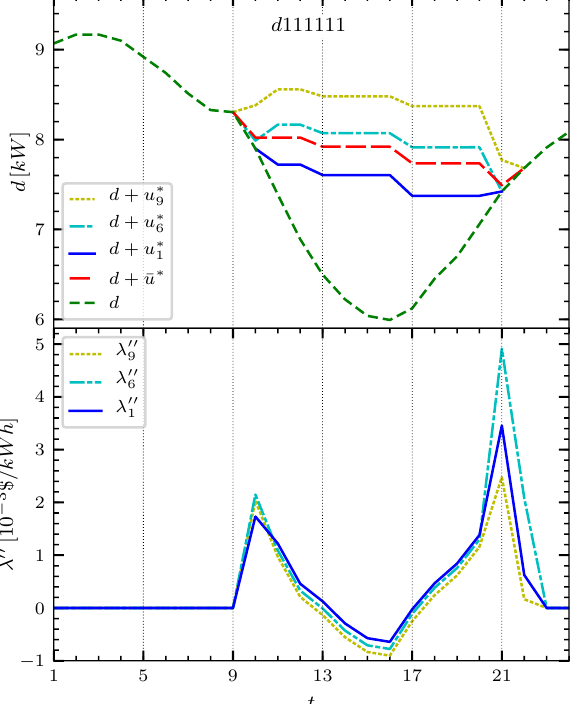
Figure 7. Upper subplot: non-PEV demand, and individual and aggregate control curves at the equi- librium summed to the non-PEV demand for the scenario “d111111”. Lower subplot: personalized taxes/incentives λ (cid:48)(cid:48) n